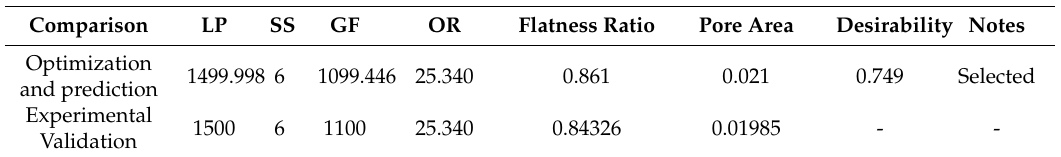
Processing parameters optimization, responses comparison between predicted and experimental validation.